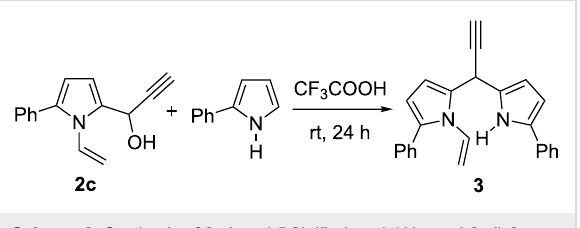
Scheme 2: Synthesis of 2-phenyl-5-[1-(5-phenyl-1 H -pyrrol-2-yl)-2- propynyl]-1-vinylpyrrole ( 3